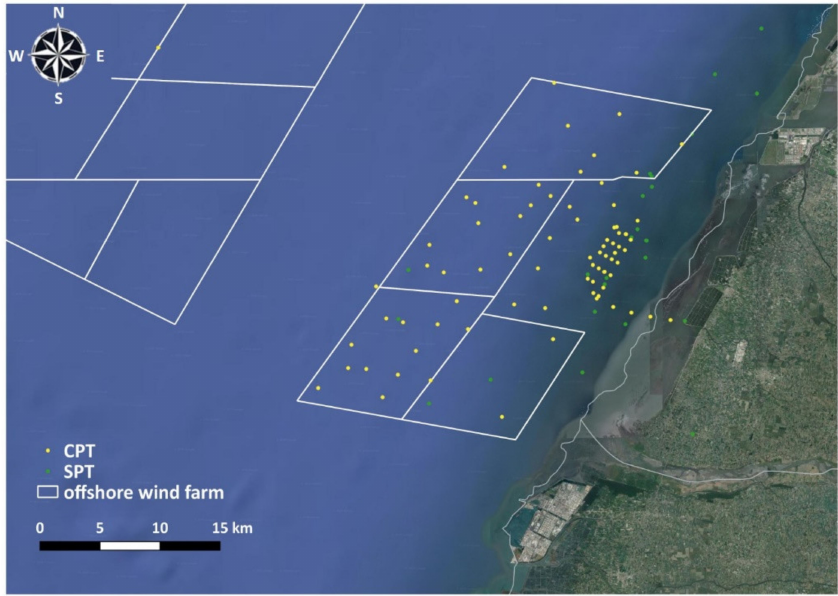
Figure 1. Locations of SPT and CPT boreholes in Changhua offshore wind farm.